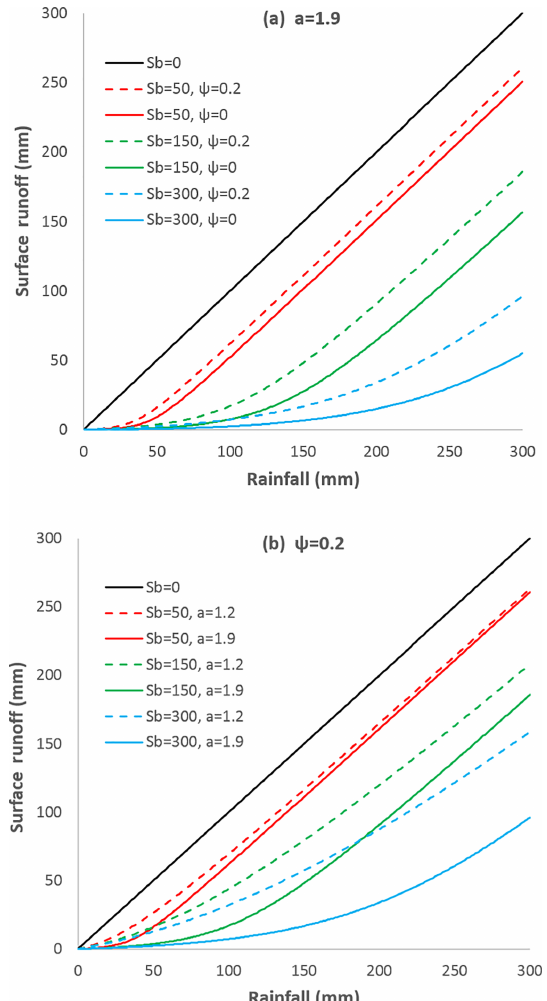
Figure 6. (a) The effects of average storage capacity and initial stor- age on the rainfall–runoff relation and (b) the effects of average stor- age capacity and shape parameter on the rainfall–runoff